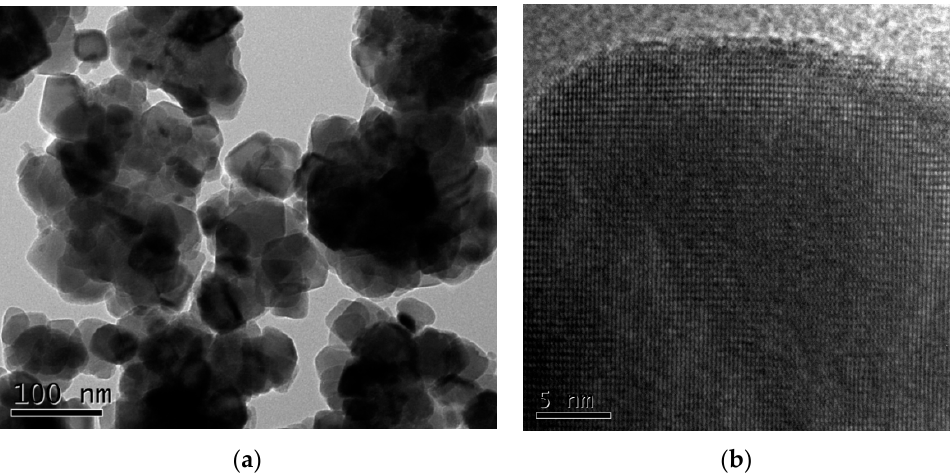
Figu re 3. ( a ) Microstructure and ( b ) high-resolution transmission electron microscopy (HRTEM) images of the Cu2O solid solution synthesized by high-frequency electromagnetic-field-assisted ball milling under aqueous